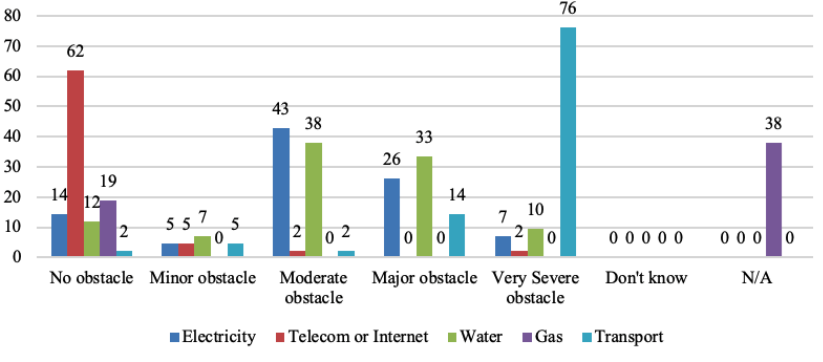
Figure 5: Elements of infrastructure